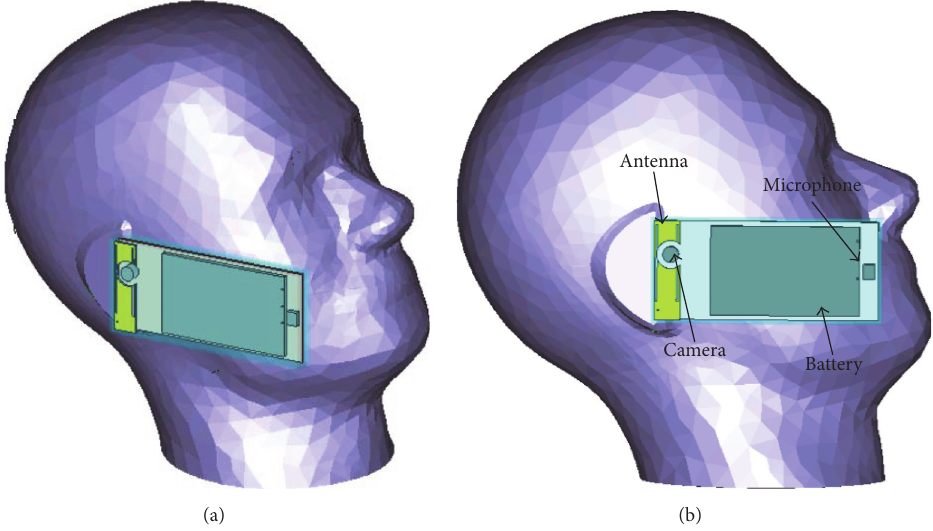
Figure 12: SAR simulation model and the mobile phone